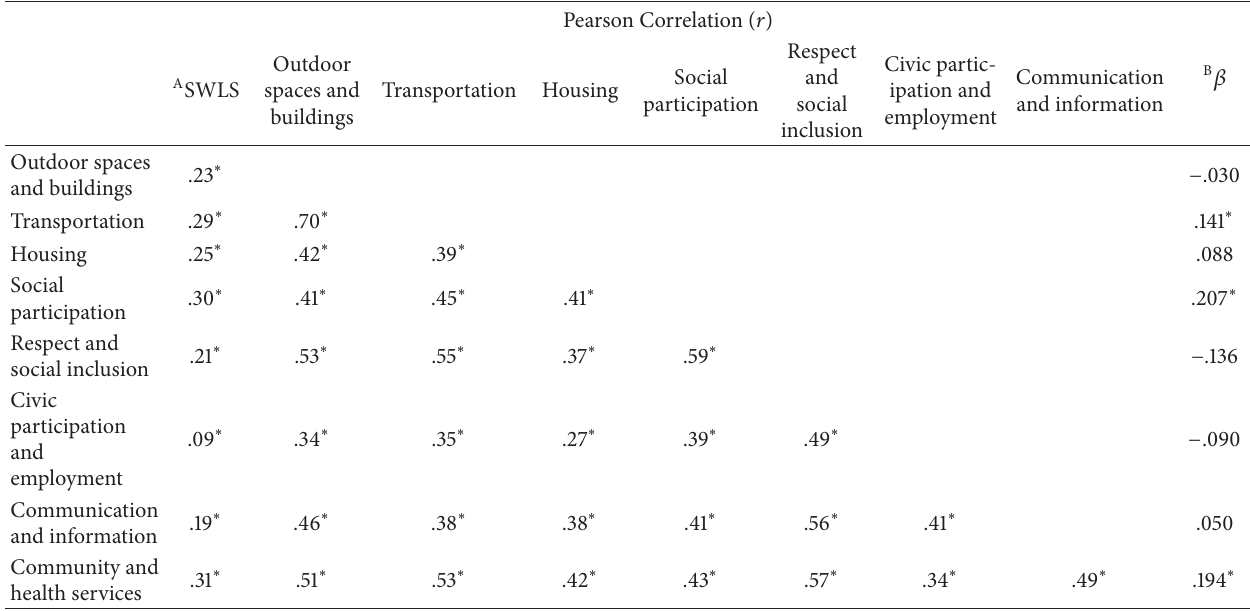
Pearson Correlation ( 𝑟 )